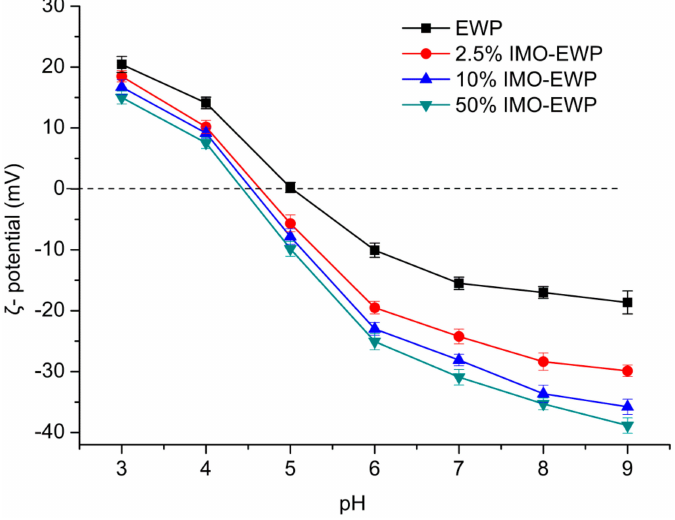
Figure 4. ζ -potentials of EWP and IMO-EWP conjugates at pH